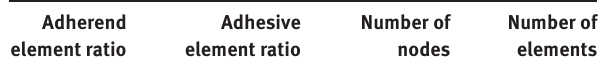
Table 4 Number of nodes and elements for 2 L = 25 mm, t